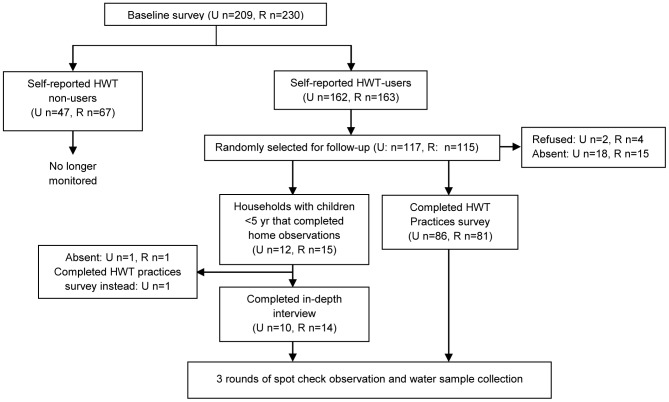
Schematic representation of the study design.